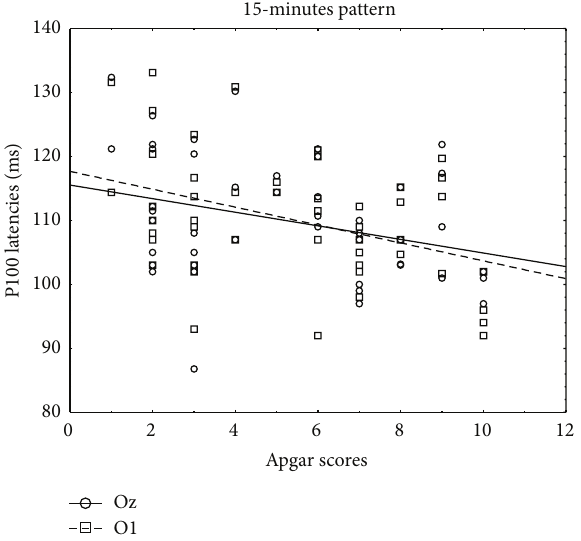
Figure 2: Scatter diagram showing a negative linear correlation betweenP100latencies(ms)andamountofApgarscorein15-minute pattern